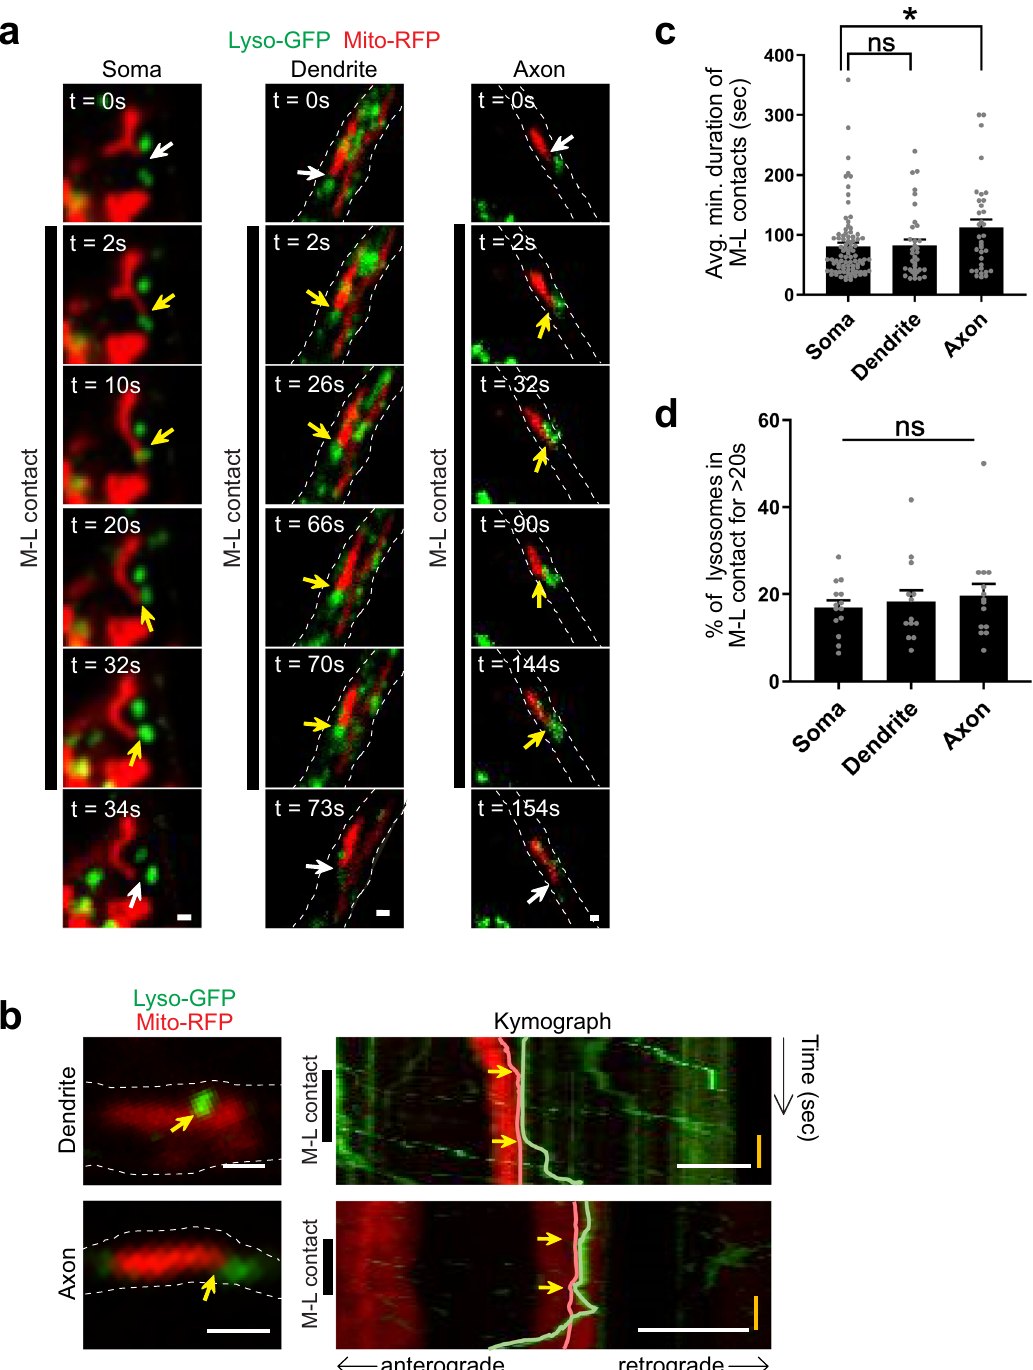
Fig. 2 Spatial compartmentalization of neuronal mitochondria – lysosome contact dynamics. a Representative time-lapse confocal images of contacts between mitochondria (red, Mito-RFP) and lysosomes (green, Lyso-GFP) in soma, dendrites, and axons of wild-type human dopaminergic iPSC-derived neurons. Time-lapse recordings were taken at 2 s intervals for 5 min. Yellow arrows mark stable M – L contacts. White arrows mark the site of M – L contacts before contact formation or after contact untethering. Black line shows duration of contacts. Scale bar = 500 nm (see Supplementary Movies 4 – 6). b Representative frames of live-cell imaging (left) and dual color kymographs (right) of M – L contacts in dendrites and axons (mitochondria: red, Mito – RFP; lysosomes: green, Lyso-GFP). In confocal image frames (left), contact sites are denoted by yellow arrows. In kymographs: white scale bar = 1 μ m, yellow vertical bar = 30 s. Yellow arrows in kymograph point to start and end timepoints of M – L contact tethering. Left black line shows duration of contacts. c , d Quanti fi cation of M – L contacts across different neuronal compartments. One-way ANOVA followed by Tukey ’ s multiple comparisons test. c Comparison of average minimum durations of M – L contacts in soma, dendrites, and axons ( n = 86 (soma), n = 35 (dendrite), n = 34 (axon) contacts from 26 neurons, N = 3 independent experiments), * p = 0.0335. d Percentage of lysosomes contacting mitochondria in soma, dendrites, and axons (for >20 s) ( n = 14 (soma), n = 13 (dendrite), n = 14 (axon) neurons; N = 3 independent experiments). For all quanti fi cations, data are means ± S.E.M; * p ≤ 0.05, ns: not signi fi